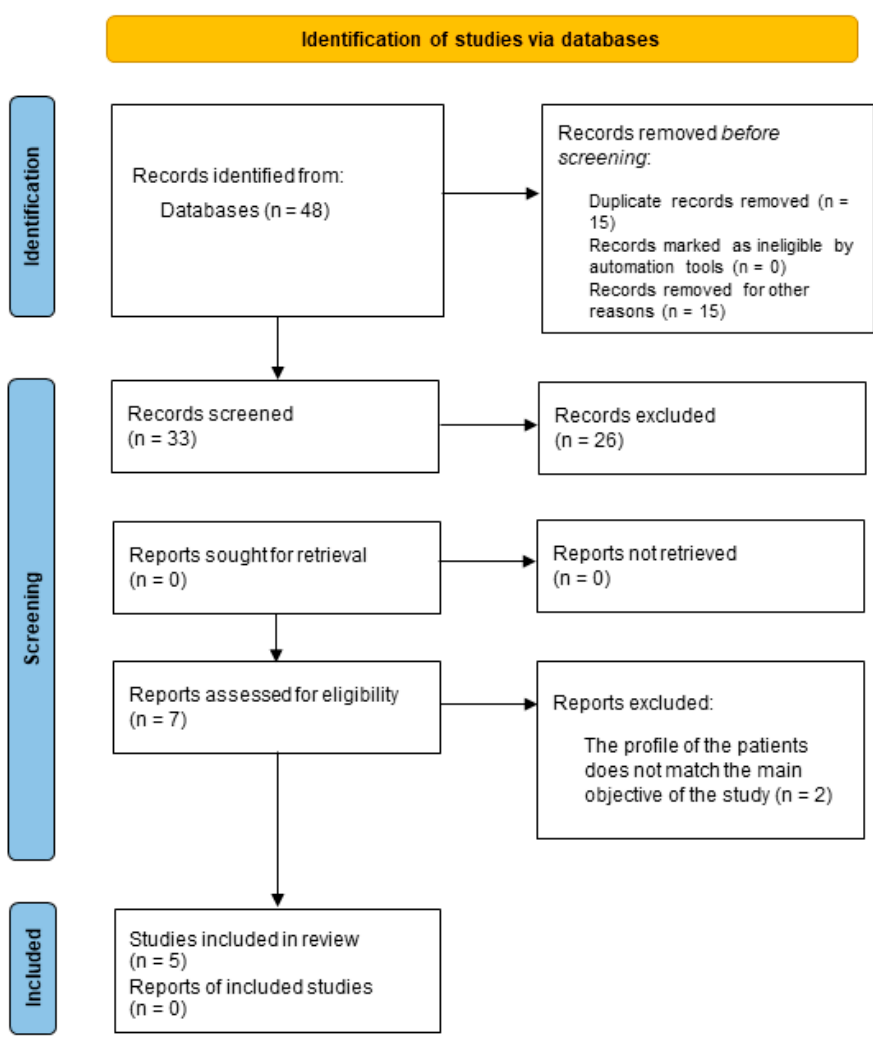
Figure 1. Flow chart of study selection process based on PRISMA guidelines.